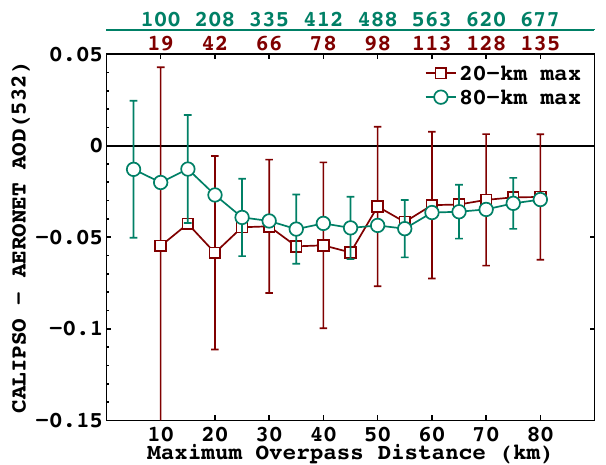
Fig. 3. Mean difference between CALIPSO and AERONET aerosol optical depths (0.532 µ m wavelength) as a function of maximum satellite overpass distance for two different averaging scales in the CALIPSO product. Sampling that allows 80-km horizontal averaging produces results similar to a subset of the data that considers only 5 or 20 km horizontal averages. The number of samples for each maximum distance are shown along the upper axes, and error bars indicate standard deviation of the mean.